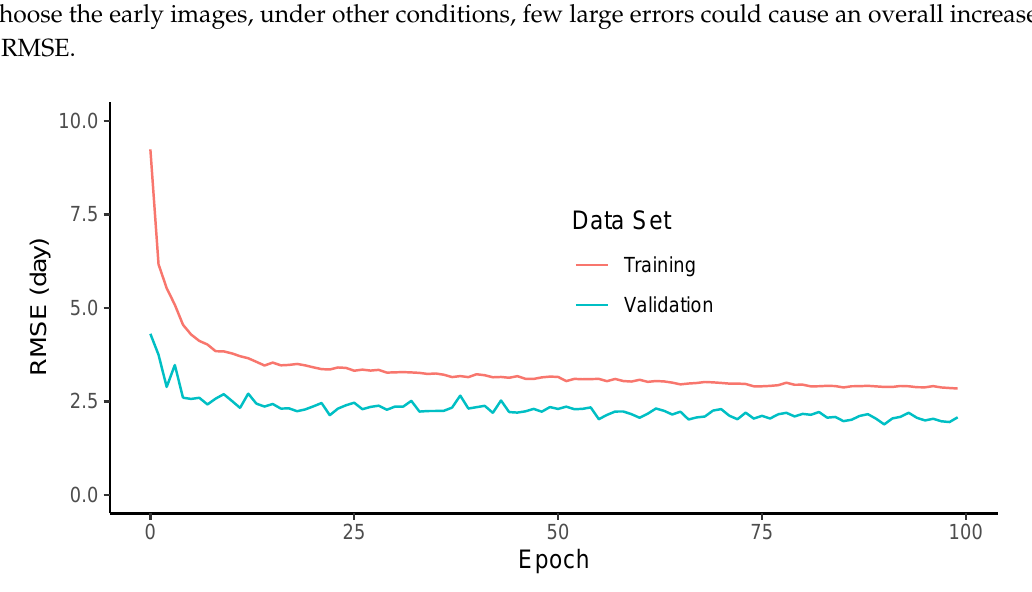
Figure 9. Prediction performance measured by the root mean squared error (RMSE) as a function of the number of iterations (epochs) for the training and validation data